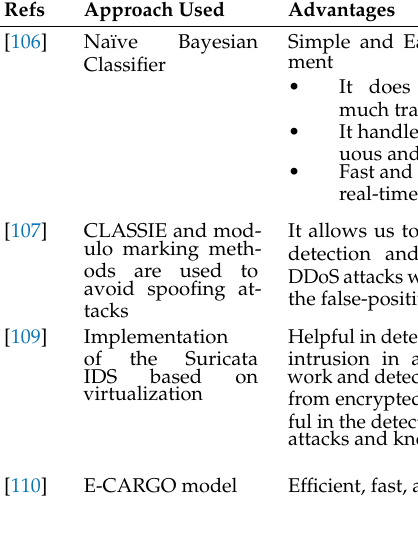
Table 8. Advantages and disadvantages of signature-based detection approach.